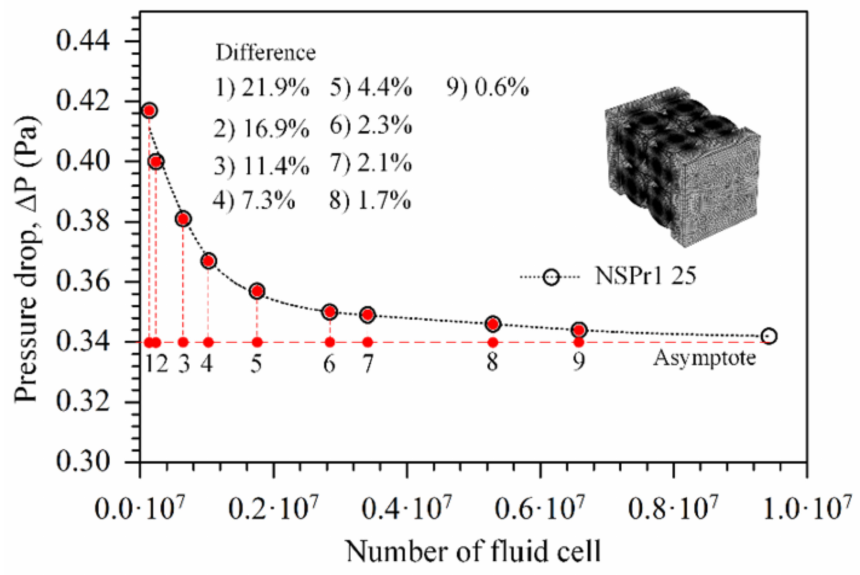
Figure 5. Mesh convergence study on one model porous scaffold NSPr1 with porosity of 25%. Table 2. Permeability value of the NSPr model, as determined by both experimental and simula- tion results.